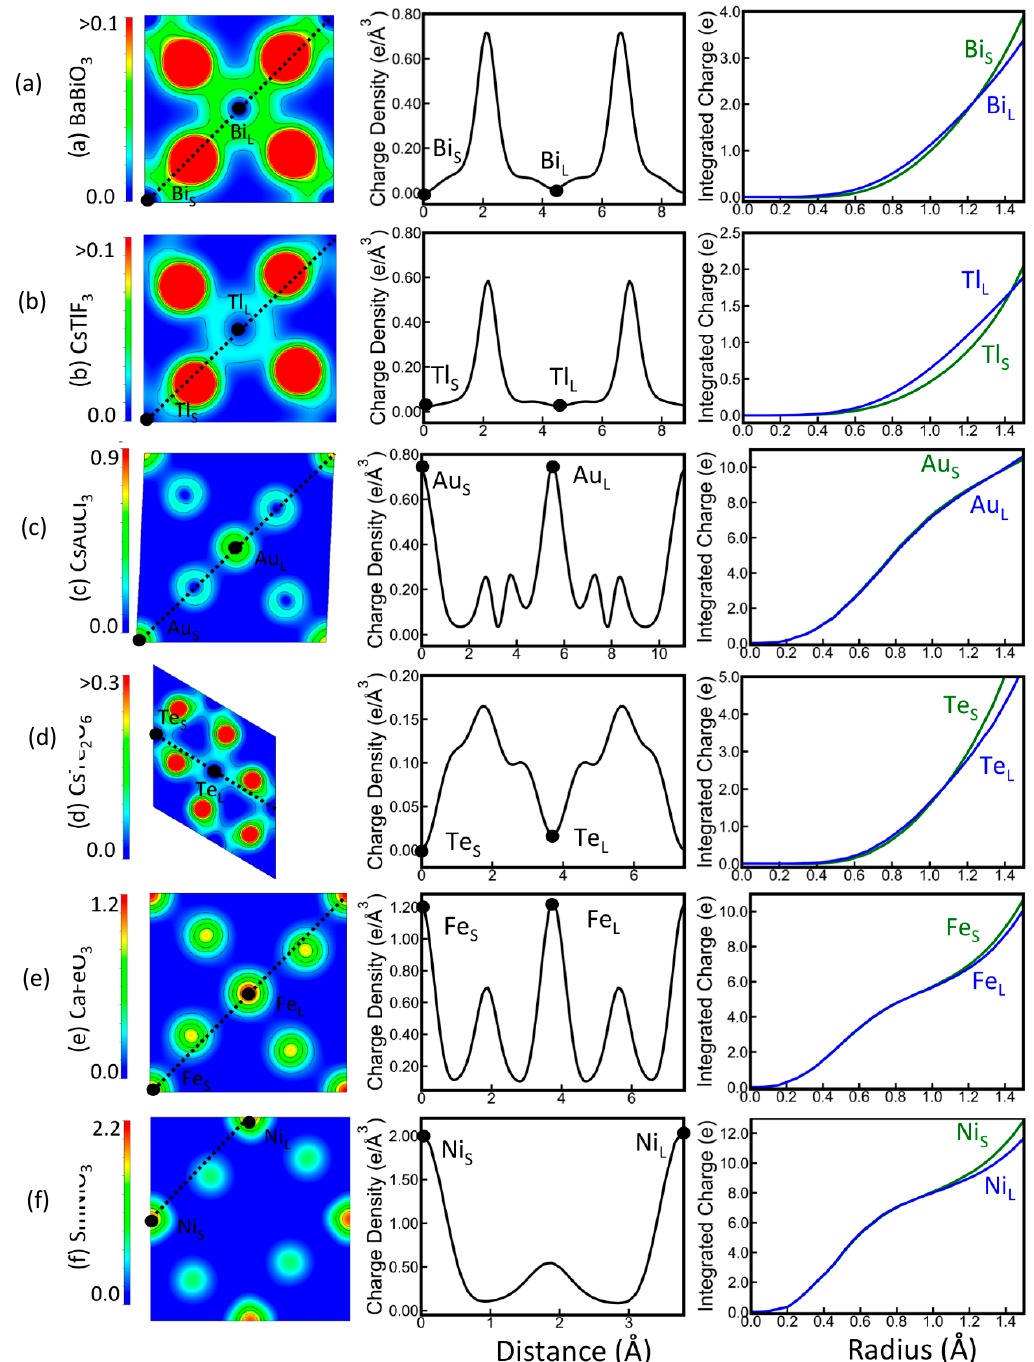
Figure 8. Charge density profiles for the DLE phase of ( a ) BaBiO 3 , ( b ) CsTlF 3 , ( c ) CsAuCl 3 , ( d ) CsTe 2 O 6 , ( e ) CaFeO 3 , and ( f ) SmNiO 3 . The images on the left represent a 2D plot of the total charge density in a plane containing the B atoms in the small ( B S ) and large ( B L ) octahedra (in units of e /Å 3 ). The central figures show a 1D plot of the total charge density along the line shown in the figures on the left. The graphs on the right represent the total charge density integrated in a sphere of radius R centered on the B S and B L atoms, as a function of R (charge accumulation function). Reprinted with permission from Ref. [20]. Copyright 2018 by the American Physical Society.